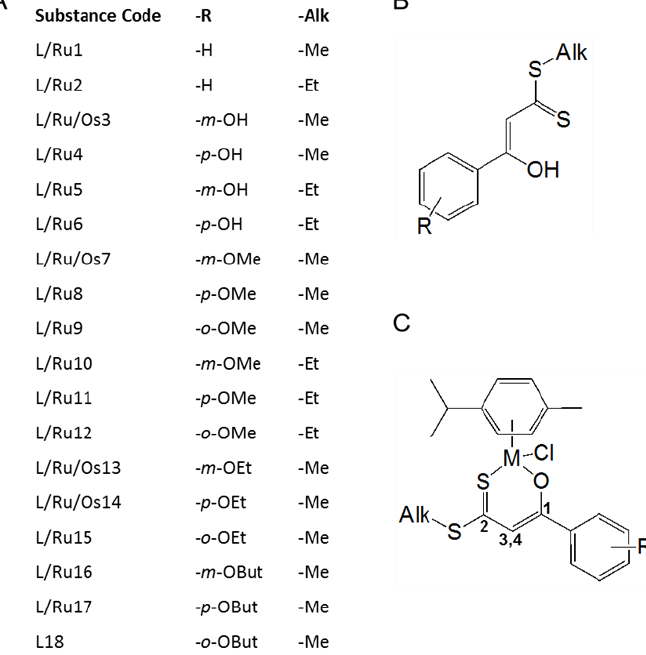
Figure 1. ( A ) Overview and substance code of compounds this work is dealing with: β -Hydroxydithiocinnamic acid esters L1-L18 and corresponding Ru complexes Ru1-Ru17 and Os compounds Os3/Os7/Os13 and Os14. ( B ) General structure of the used ligand system. ( C ) Structure of analysed complexes with numbers indicating atoms discussed for their NMR signals (Table 1).